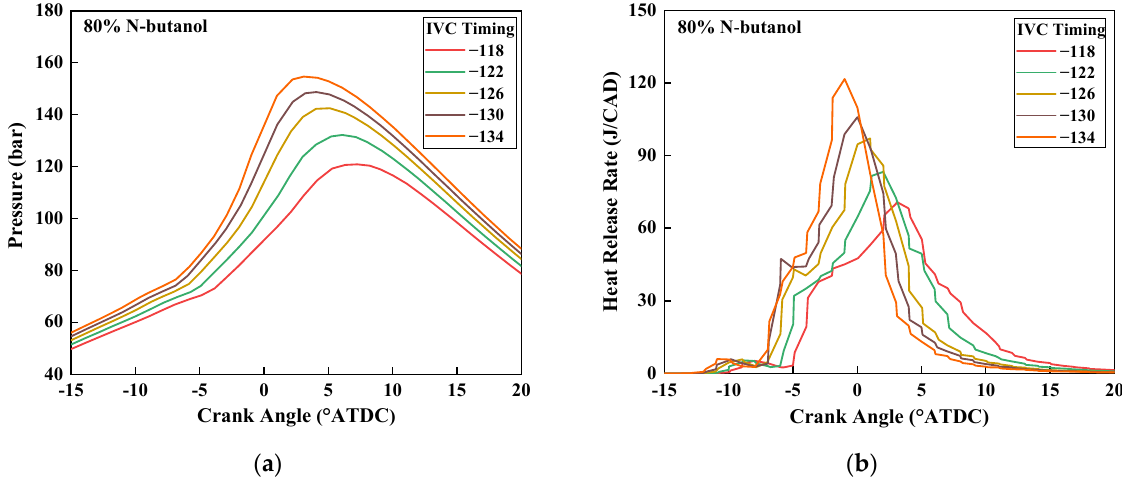
Figure 15. Comparison of in-cylinder pressure and HRR under different IVC timings: ( a ) in-cylinder pressure, ( b ) HRR.